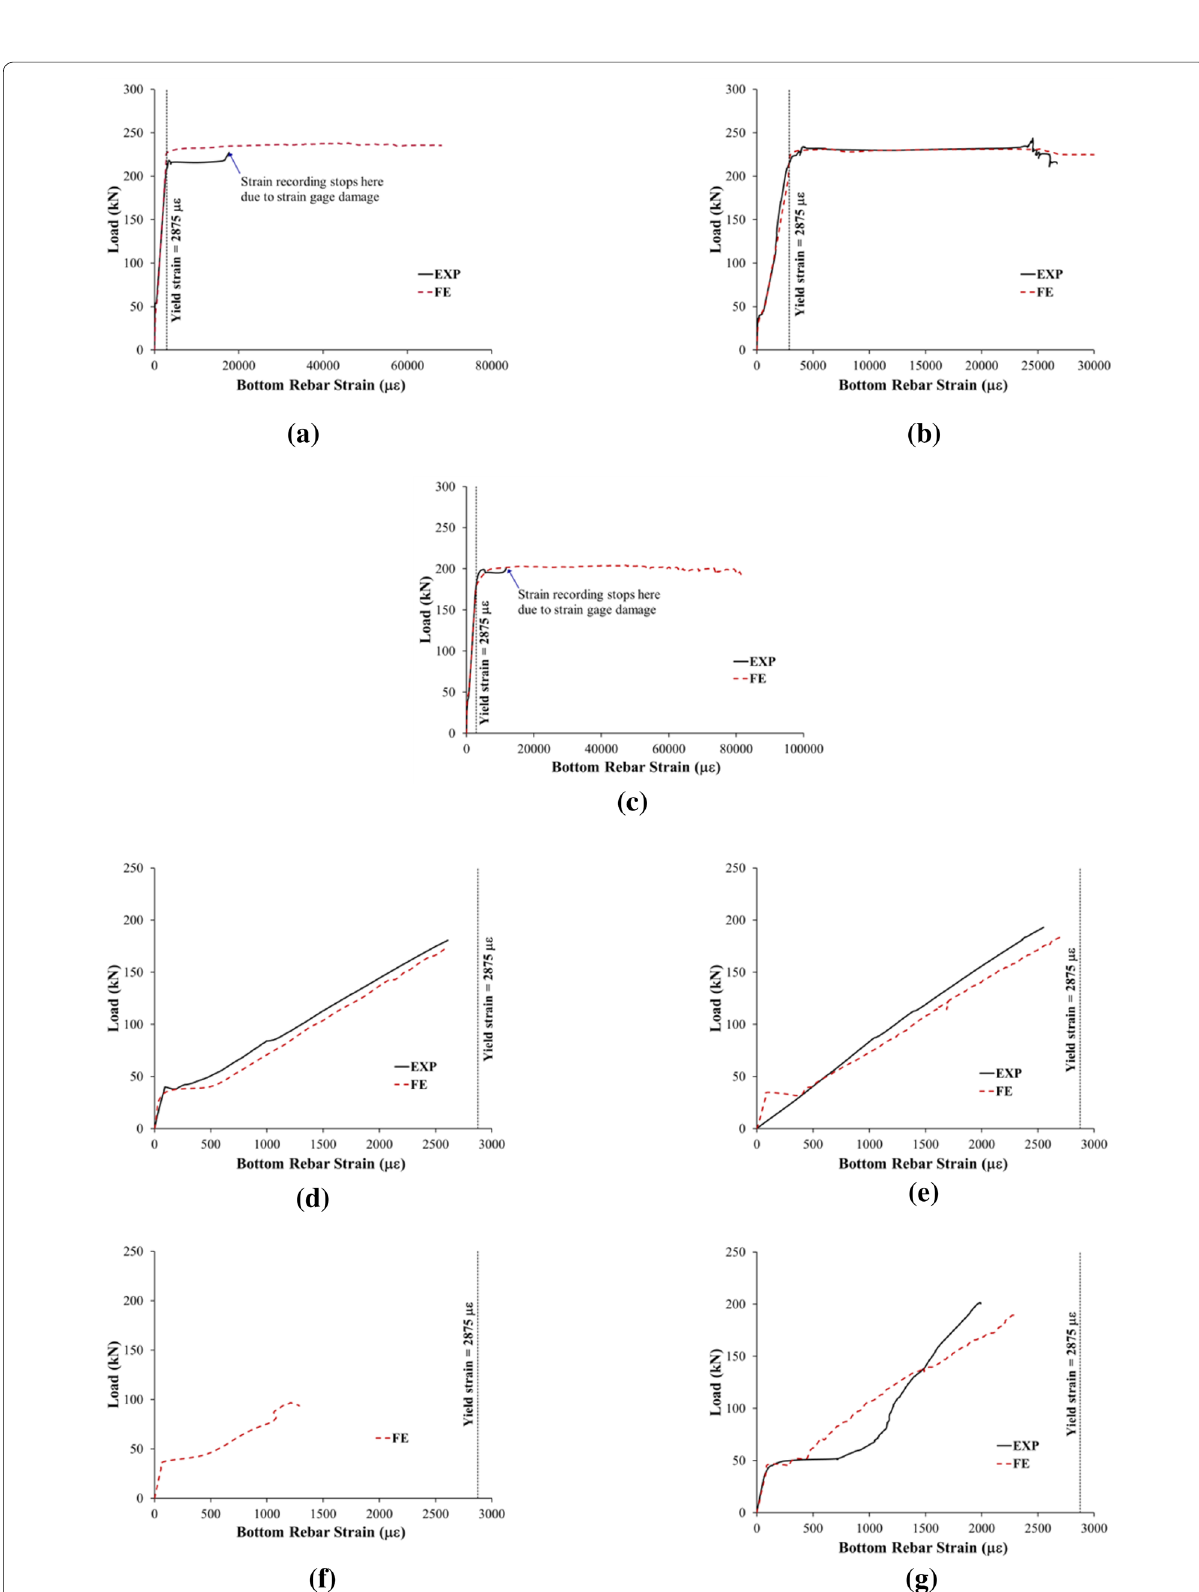
Fig. 14 Comparison curves of experimental and FE load versus strain of bottom rebars at mid‑span of: a BC‑N‑4PB, b BC‑O1‑4PB, c BC‑N‑CPL, d BC‑O1‑CPL, e BS1‑O1‑CPL, f BC‑O2‑CPL, and g